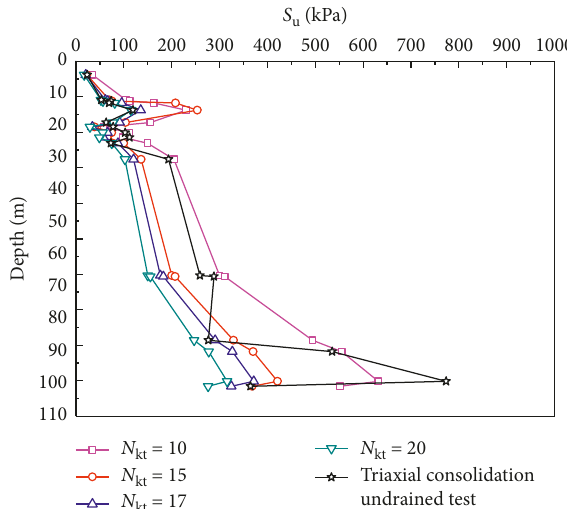
Figure 11: Comparison of the sensitivity results of laboratory tests and CPT tests using different N s values.